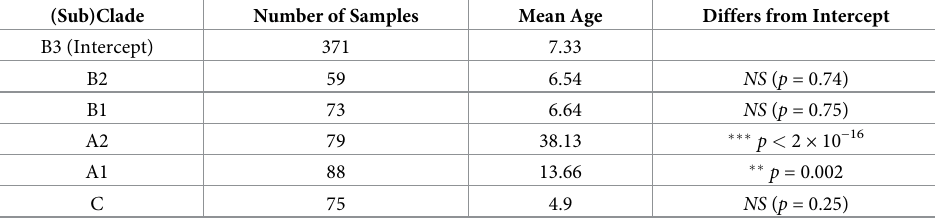
Table 2. Age and Clade/Subclade. Linear model of subclade on age, showing the ages of patients in subclades A2 and A1 are significantly different from those in subclade B3. Subclades B2, B1, and C do not differ significantly from B3. Number of samples refers to the number of samples within a subclade for which exact age data was available.